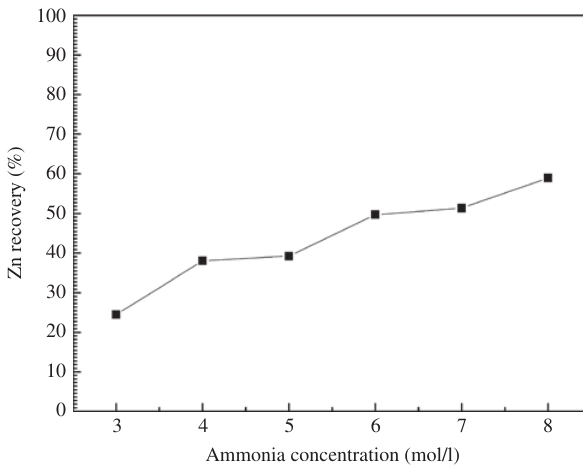
Figure 2: Effects of total ammonia concentrations on zinc recover- ies of unroasted ores.